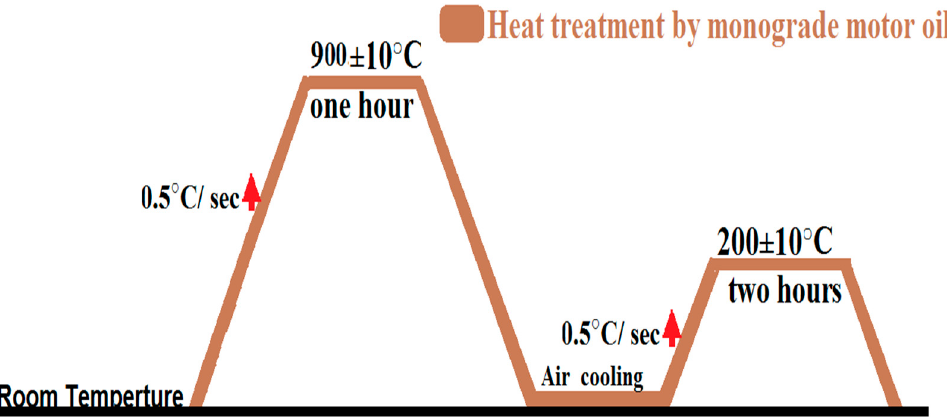
Figure 1. The Schematic diagram for the heat ‐ treatment mechanism.